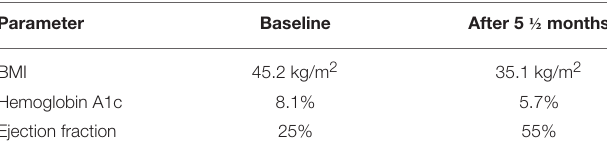
TABLE 2 | Health parameters at baseline and after five and a half months on a plant-based diet.